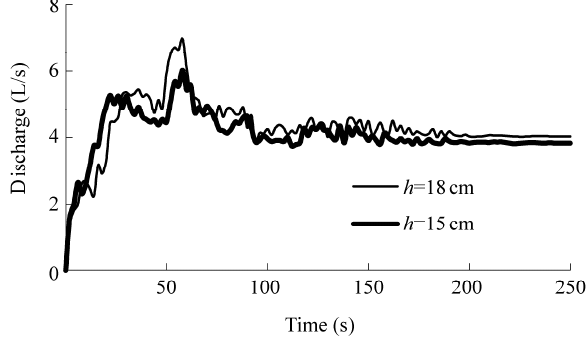
Fig. 8 Flow rate through the breach. Fig. 8. Flow rate through the